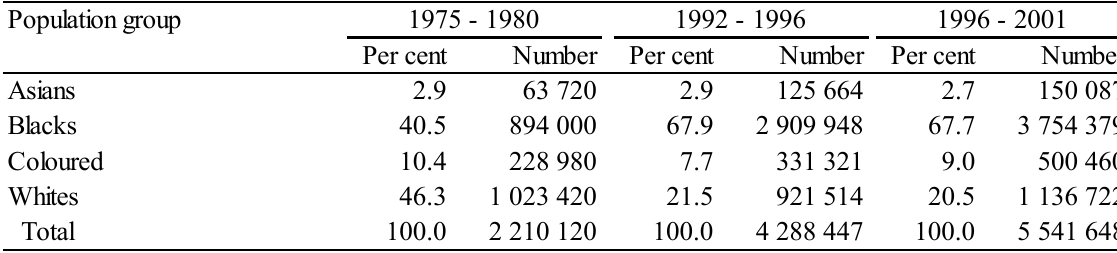
Table 2: Number of immigrants into South Africa by population group, 2001